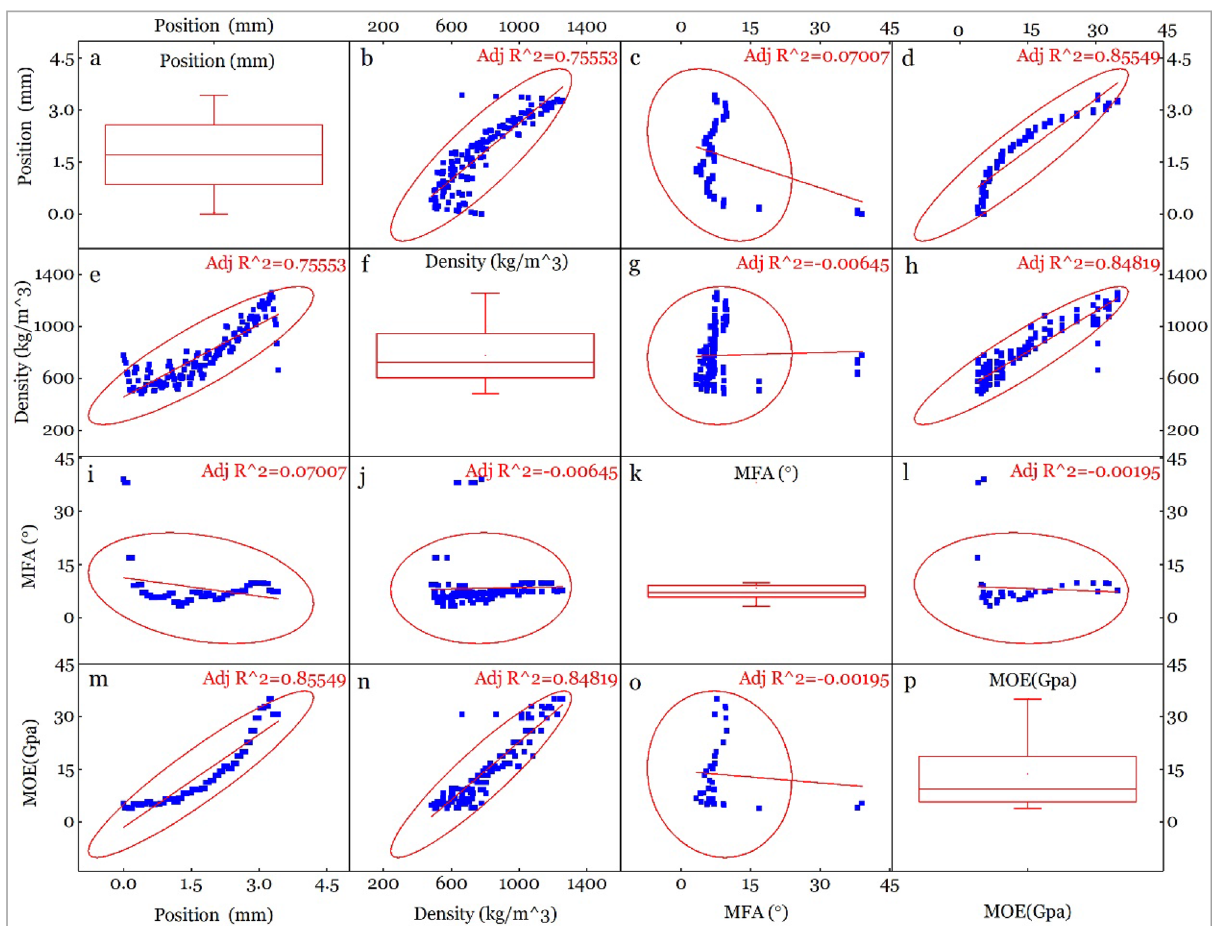
Figure 7. Correlation between position, density, MFA and MOE of neutral